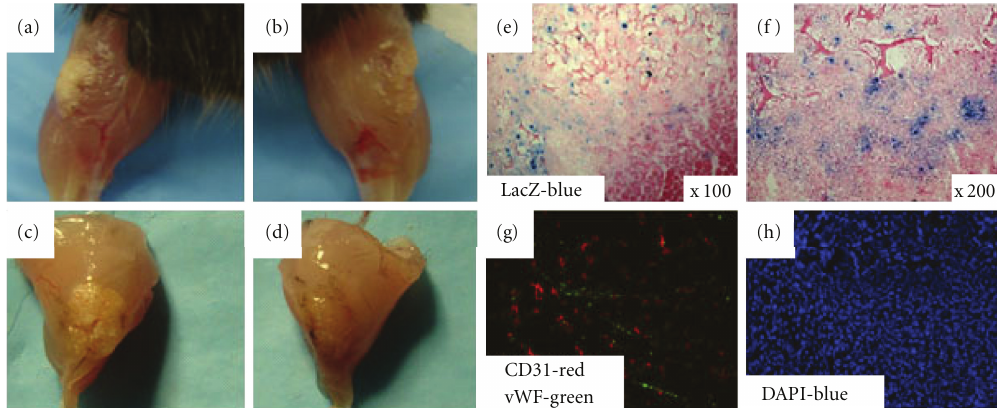
Figure 4: In the mdx /SCID mouse model, healthy healing was observed in the myoblast seeded sca ff olds after 10 days (a) and 20 days (c). Nonseeded sca ff olds implanted into mdx /SCID mice resulted in slower and less healthy healing at 10 days (b) and 20 days (d). LacZ staining of the implanted muscle graft region revealed extensive migration of the LacZ + myoblasts into the surrounding host tissue (e) and (f). Immunofluorescent staining of CD31 ( red ) and vWF ( green ) showed vascularization developing in the implanted muscle graft region 20 days after implantation (g). A DAPI staining revealed that a variety of cell types were located homogenously throughout the implanted muscle graft area (h).